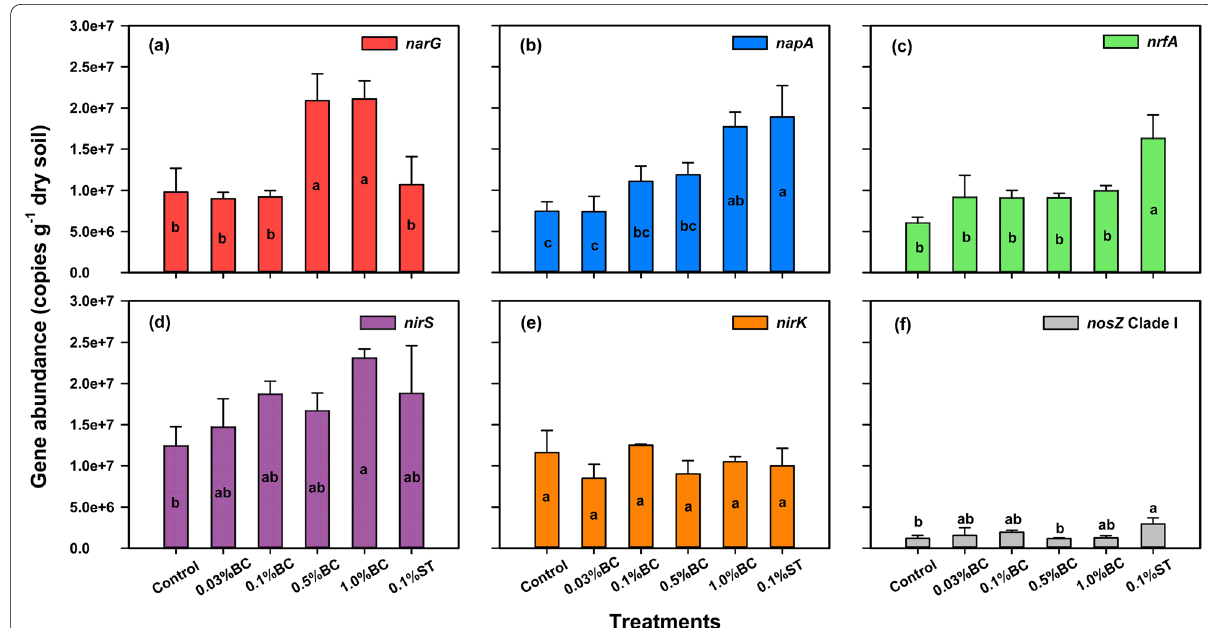
Fig. 2 Nitrate reduction-related gene [ narG ( a ), napA ( b ), nrfA ( c ), nirS ( d ), nirK ( e ), and nosZ Clade I ( f )] abundance in the Control, 0.03%BC, 0.1%BC, 0.5%BC, 1.0%BC, and 0.1%ST treatments. Error bars show the standard deviation of each treatment ( n differences at P <